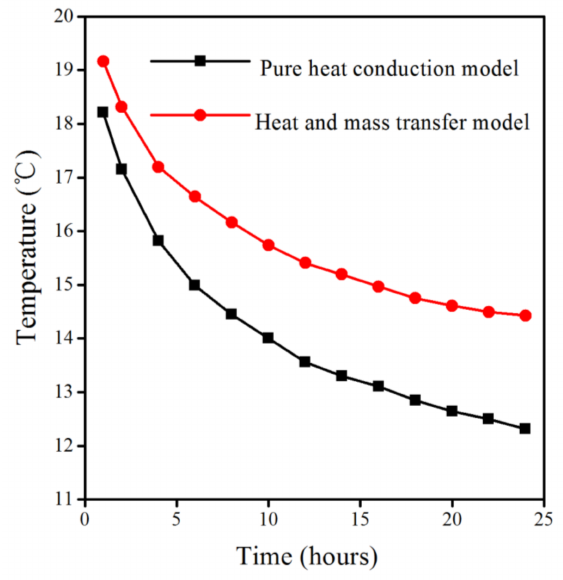
Figure 11. The difference between inlet air temperature and outlet air temperature for different heat transfer models.